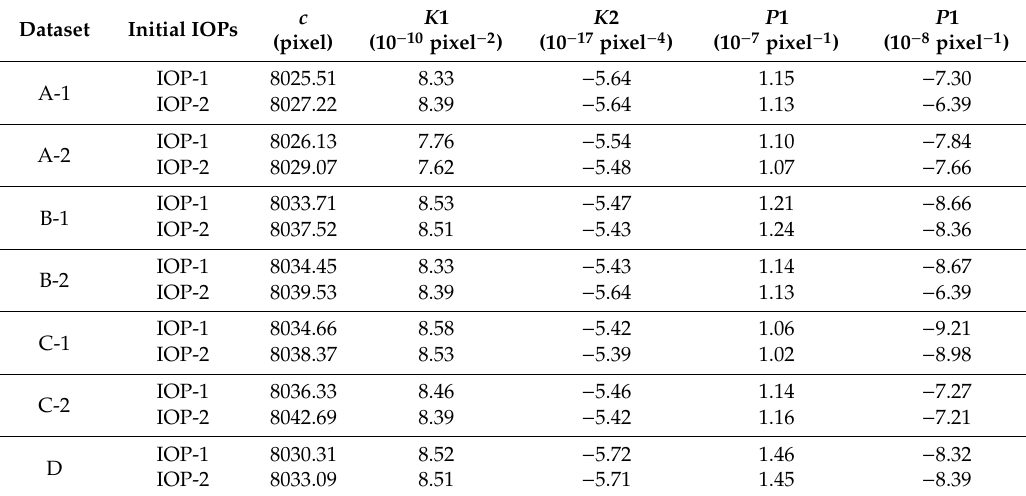
Table 10. Refined IOPs derived from IOP-1 and IOP-2 as initial values for the seven datasets.